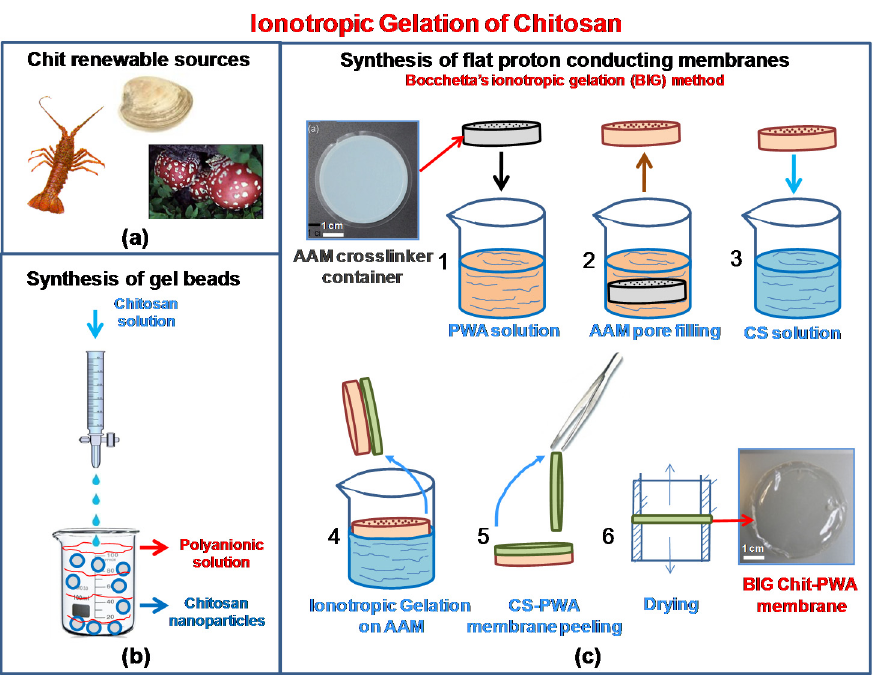
Figure 1. Chitosan renewable sources ( a ); Scheme of ionotropic gelation of chitosan through cross-linking for the formation of ( b ) gel beads; ( c ) proton conducting flat structures (BIG method).